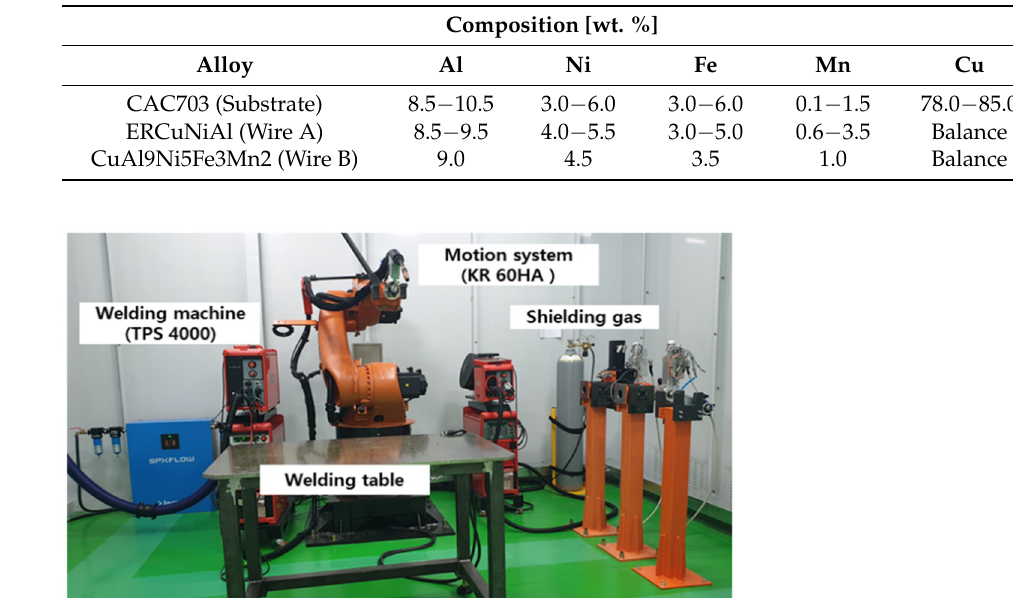
Table 1. Chemical compositions and mechanical properties of materials (wt. %) Composition [wt. %]